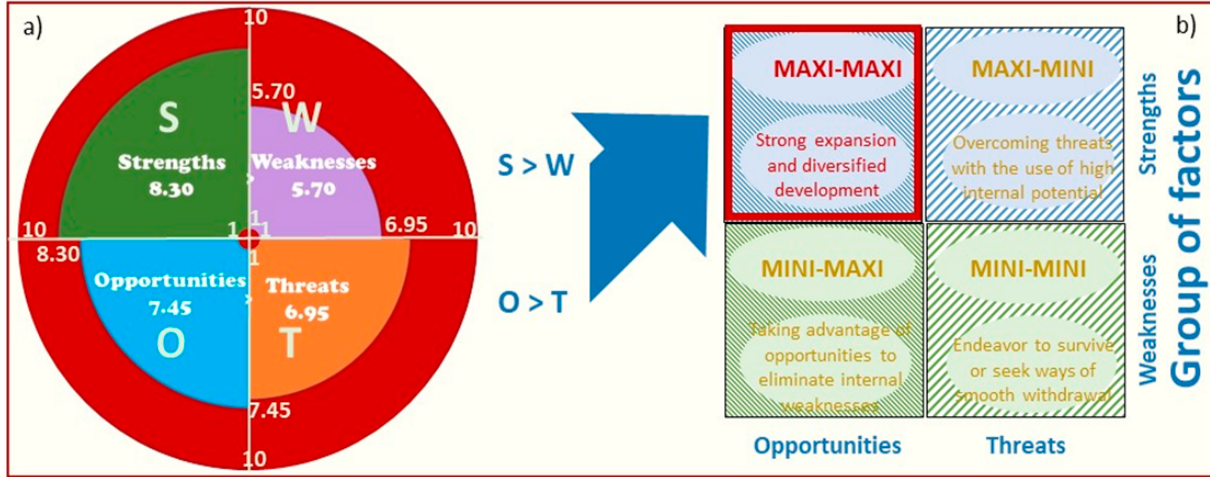
Figure 21. Scheme of the results of the SWOT analysis concerning the filling material based on gutta-percha with the numerical reflection of individual aspects of the assessment indicating the advantage of strengths and opportunities (the field area corresponds to the numerical rating of each analysis factor) ( a ) and their impact selection of the MAXI-MAXI strategy among four possible strategies ( b ).